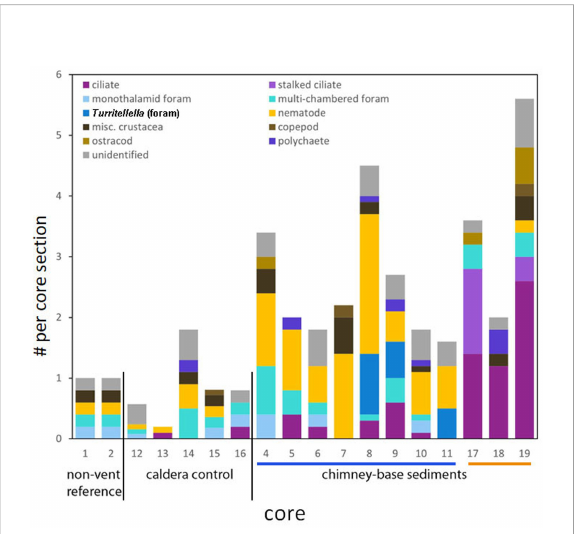
FIGURE 3 Stacked bar graph showing eukaryote abundance by major group/ taxa of interest for each core, ordered by habitat. The bars under the x-axis denote the two chimneys: Daimyojin Chimney with >20m height is the blue bar; smaller chimney with ~2m height is the orange bar. Values are standardized per core section. Turritellella foraminifer counts are not included in the Multi-chamber foraminifera category. Flagellates not